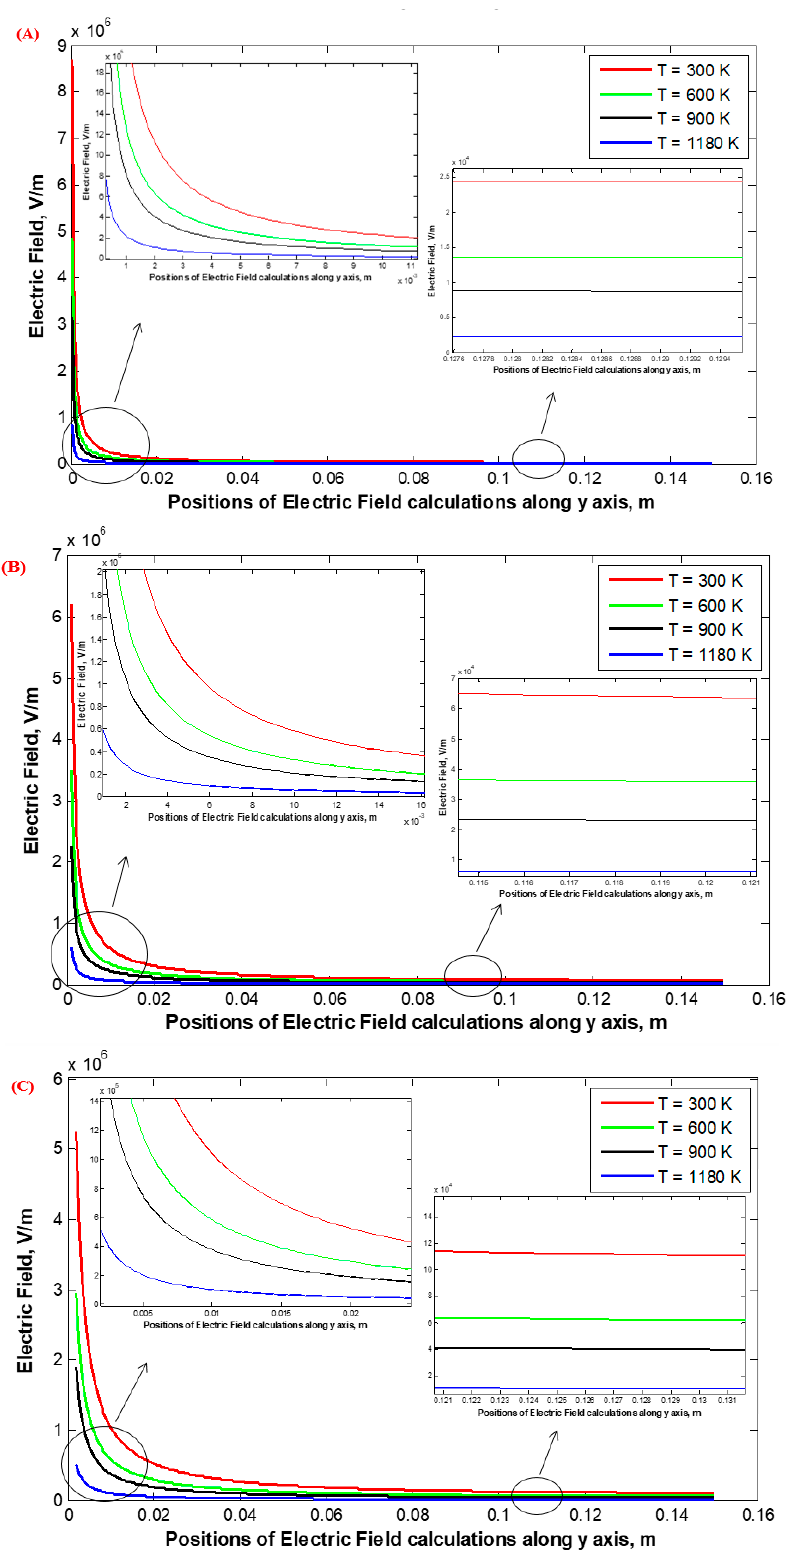
Figure 18. Electrostatic field along the Y -axis of the single-discharge wire WDESP at a high temperature: ( A ) r c = 0.26, ( B ) r c = 0.935, and ( C ) r c = 1.975 mm.